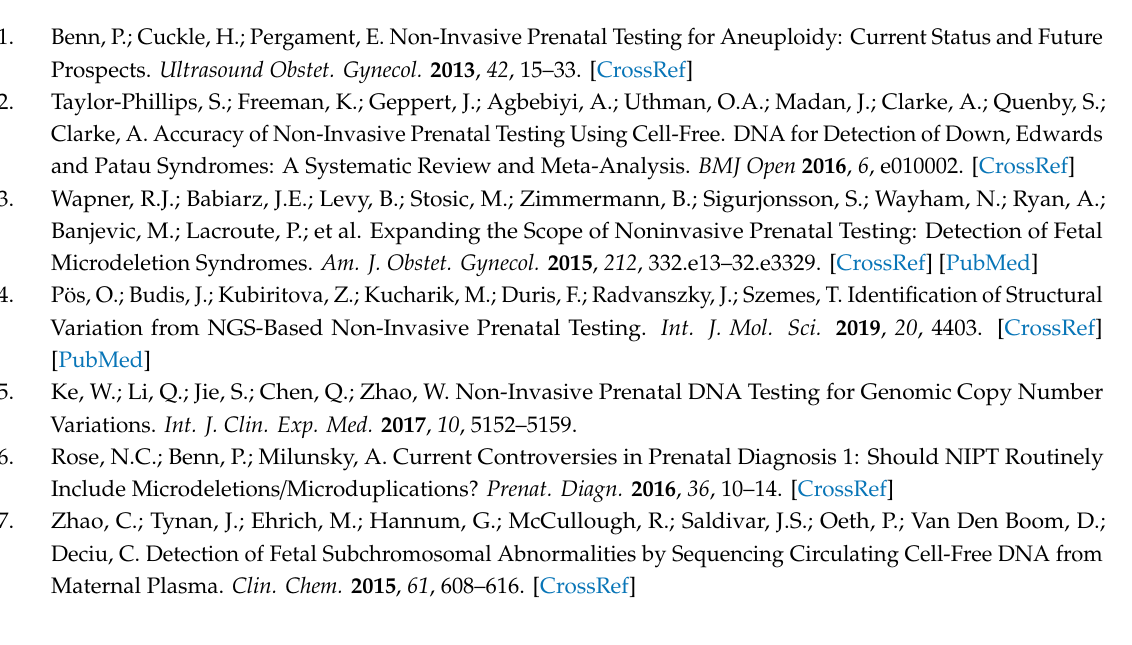
Table S1: Video S1: Detected fetal CNVs, samples sorted according to fetal fraction; Table S2: Detected fetomaternal / maternal CNVs, samples sorted according to fetal